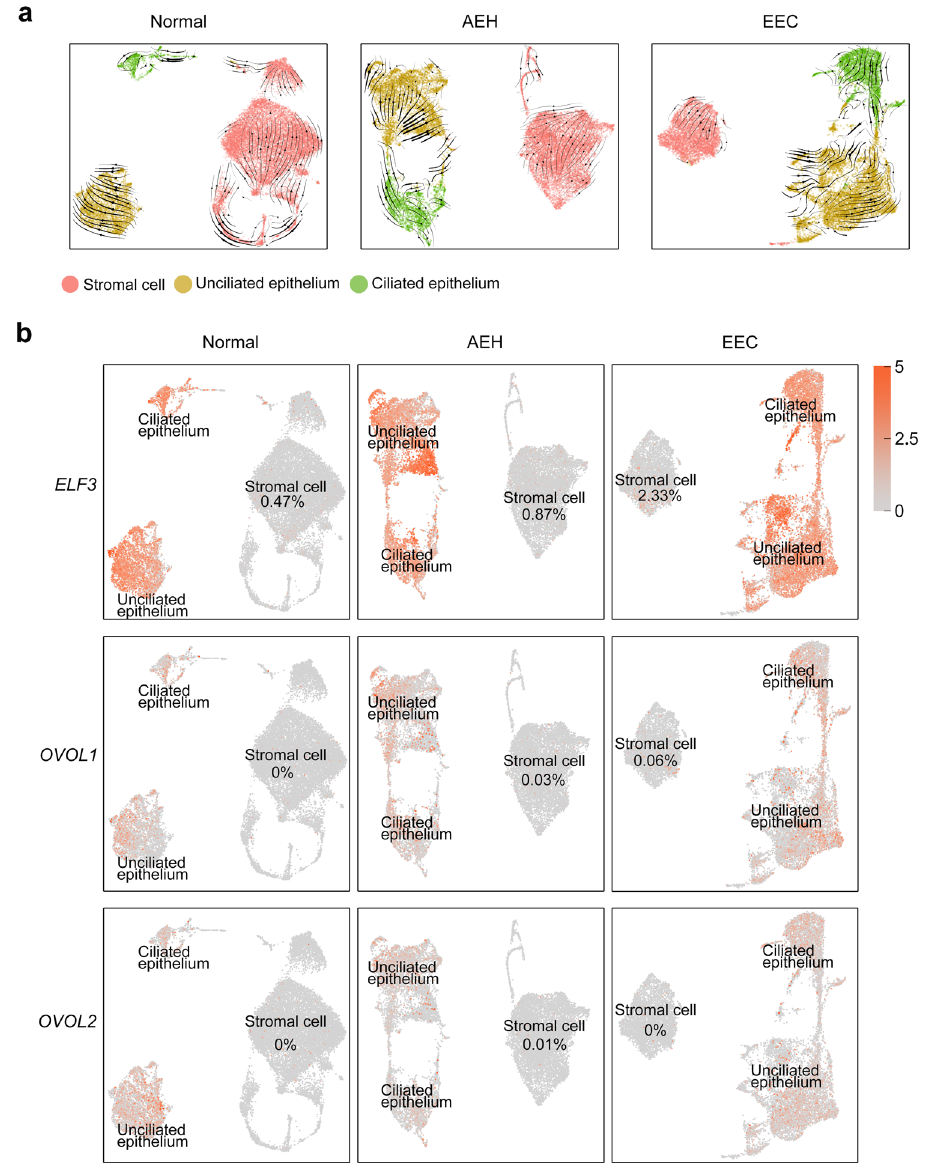
Fig.2|Lineagetrajectoryofepitheliumandstromal fi broblastsshowedbyRNA velocity analysis. a RNA velocity suggests no lineage trajectory between epithe- lium cells and stromal fi broblast cells in different endometrial pathology stages.